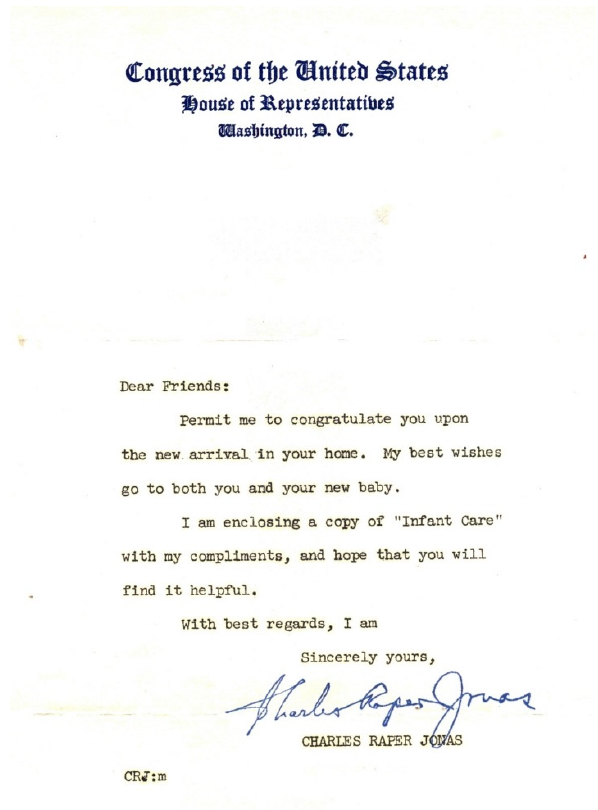
Figure 4. Letter from Congressman to Constituent Accompanying Infant Care Booklet.